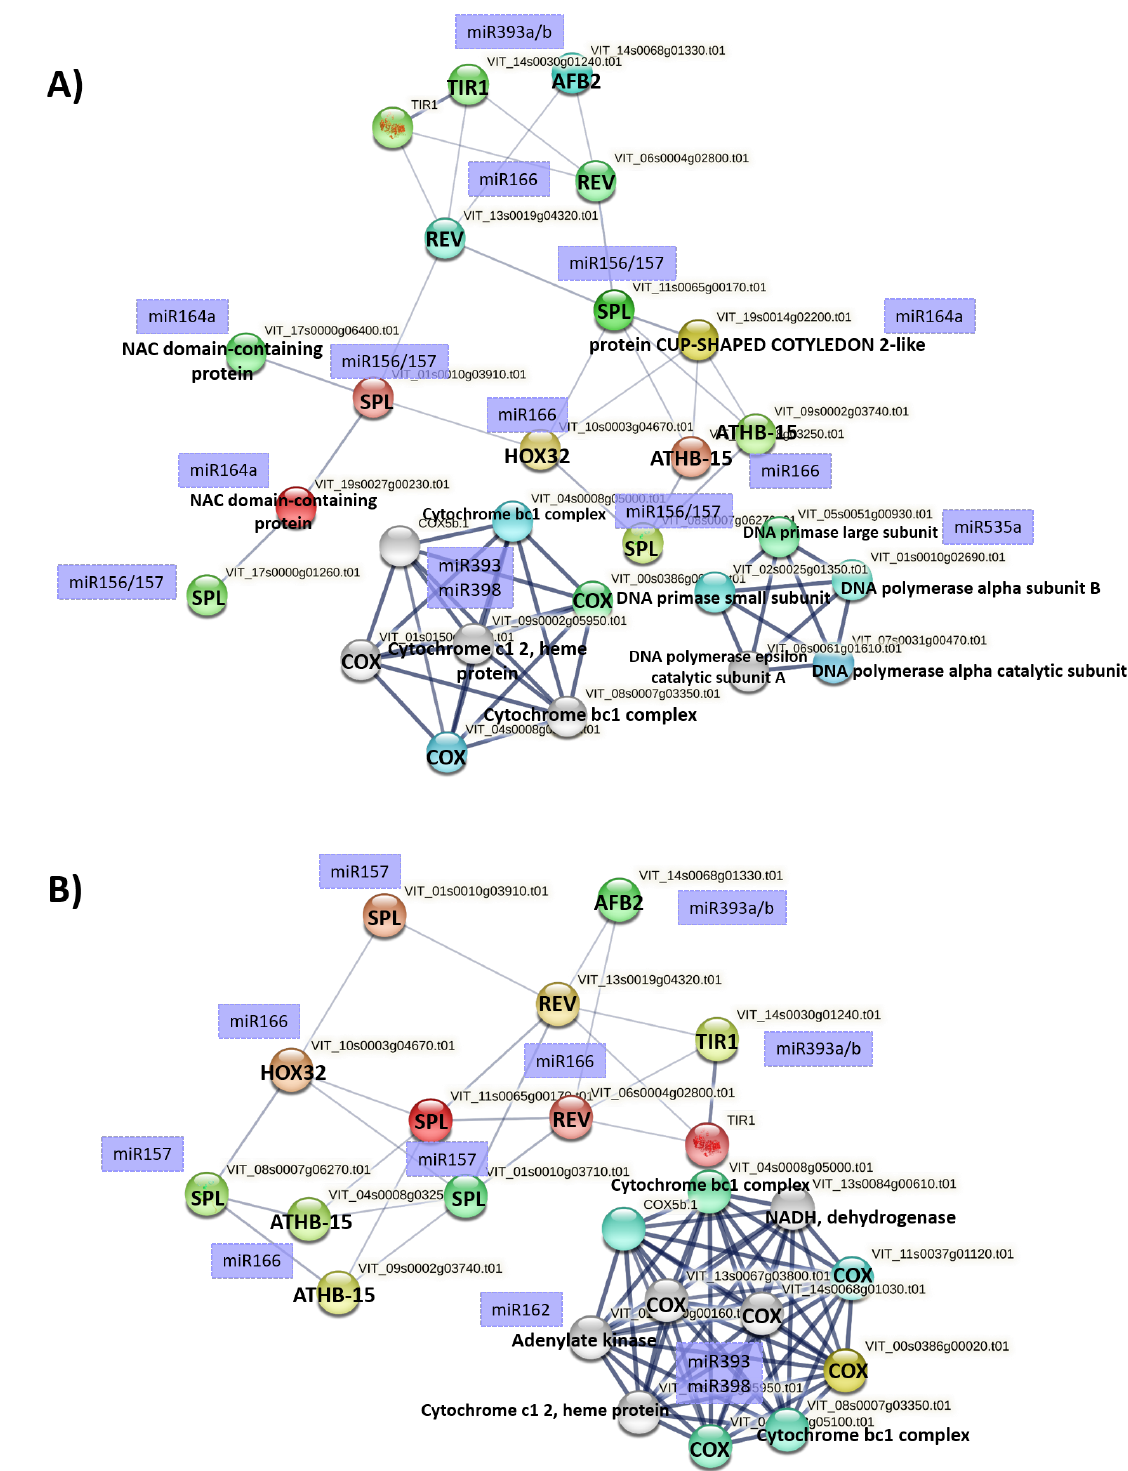
Figure 6. STRING network view of known and predicted interaction partners for targets of miRNAs upregulated by HTT — 40 °C in ( A ) R. irregulare, and ( B ) F. mosseae inoculated plants. Predicted miRNA targets were utilized to query orthologous proteins in grapevine. The confidence view screen shows established and predicted protein–protein interactions, with stronger associations represented by thicker lines (edge confidence